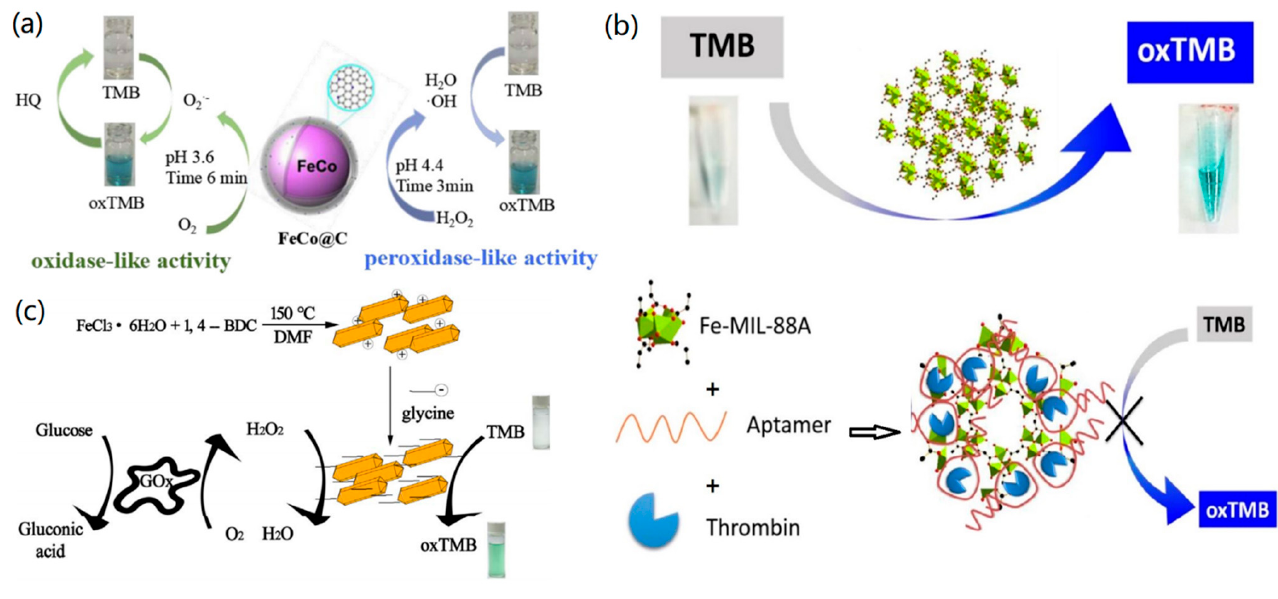
Figure 10. ( a ) FeCo@C catalyzed oxidation of TMB. Reprinted with permission from Ref. [91], Copyright 2019, Elsevier. ( b ) Aptamer-modified MOF for unlabeled thrombin. Reproduced with permission from Ref. [94]. Copyright 2016, Elsevier. ( c ) Fe-MIL-88A for thrombin. Reprinted with permission from Ref. [95], Copyright 2017, Elsevier.